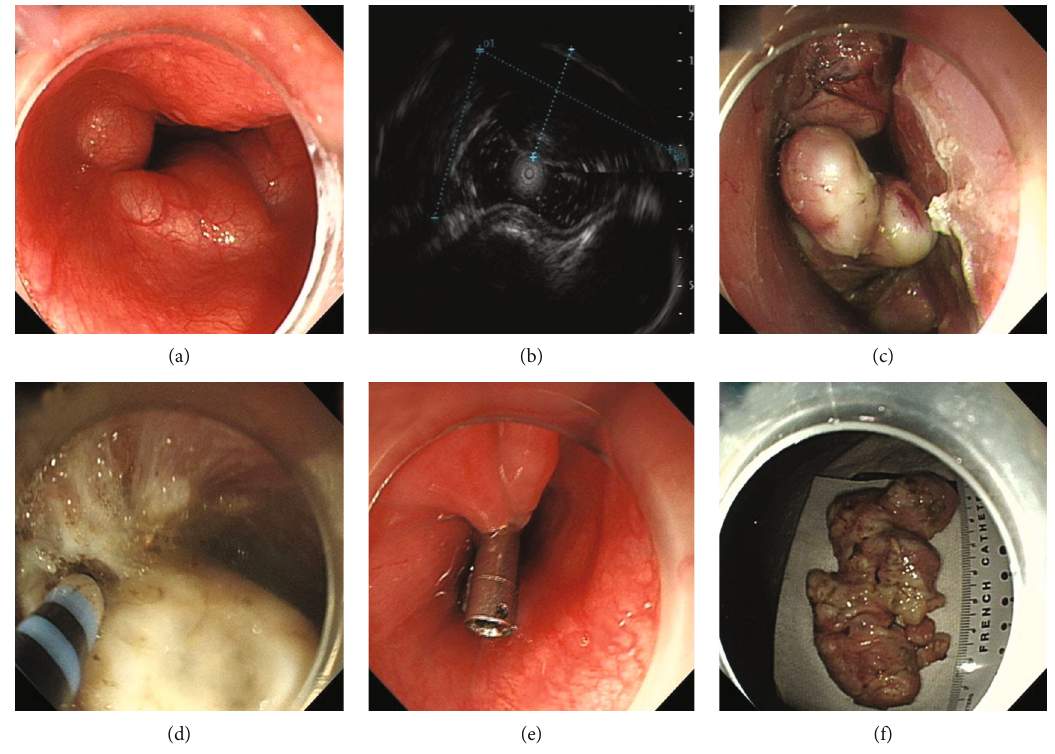
Figure 5: Submucosal tunneling endoscopic resection treatment for a gastric GIST: (a) gastric GIST identi fi ed by endoscopy; (b) the same gastric GIST observed by endoscopic ultrasound; (c, d) resection of the tumor via submucosal tunneling; (e) close the wound; (f) the resected tumor. GIST: gastrointestinal stromal tumor.